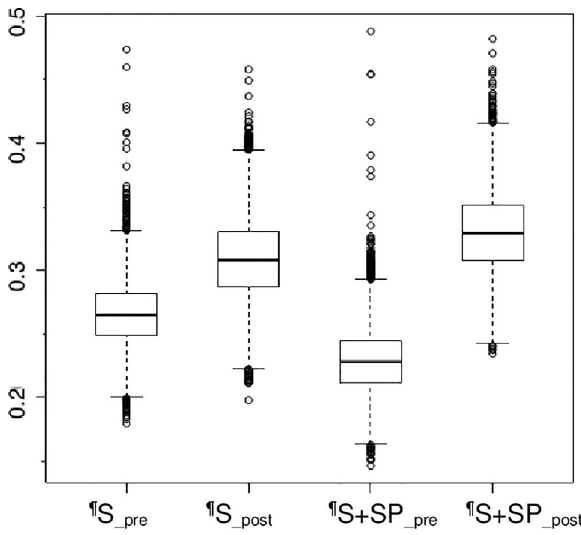
Figure 4 - Box plot of the posterior probability of volleyball ‘kill’ in the attack in the Skill (S) and Skill and strength/power (S+SP) groups in the pre- and post-training assessments 36 .